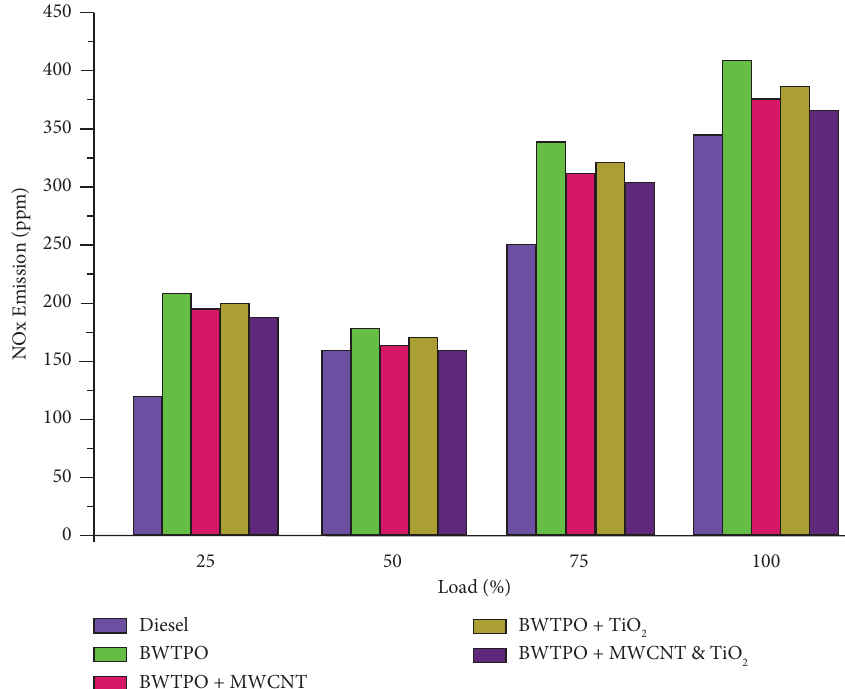
Figure 10: Relationship between NOx (ppm) and load variations